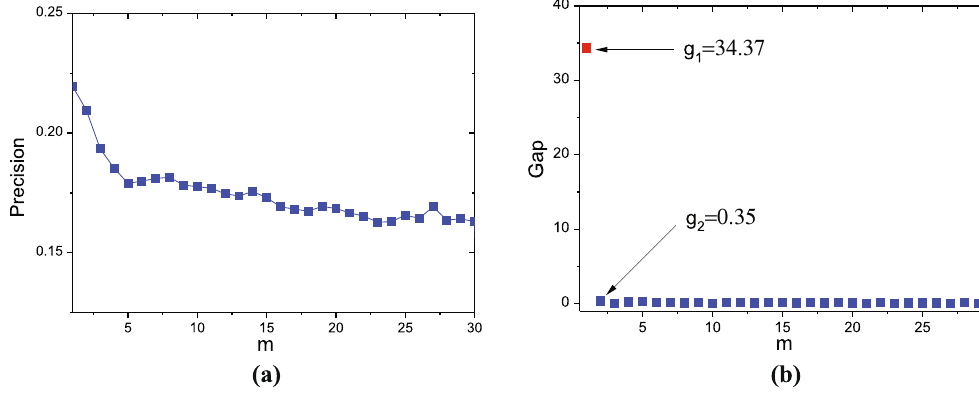
for Hypertext. λ m is the eigenvalue of adjacent m m m 1 and λ + . m m 1